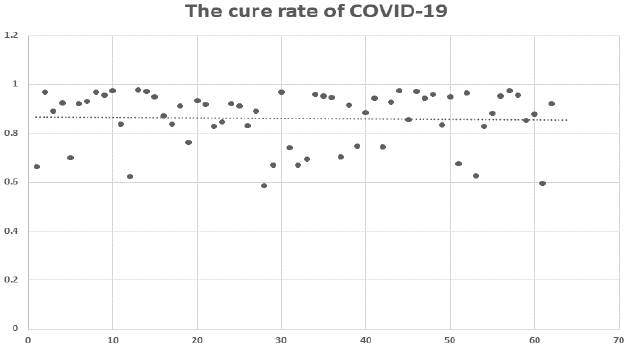
Figure 3. Cure rates of COVID-19 of 62 countries.